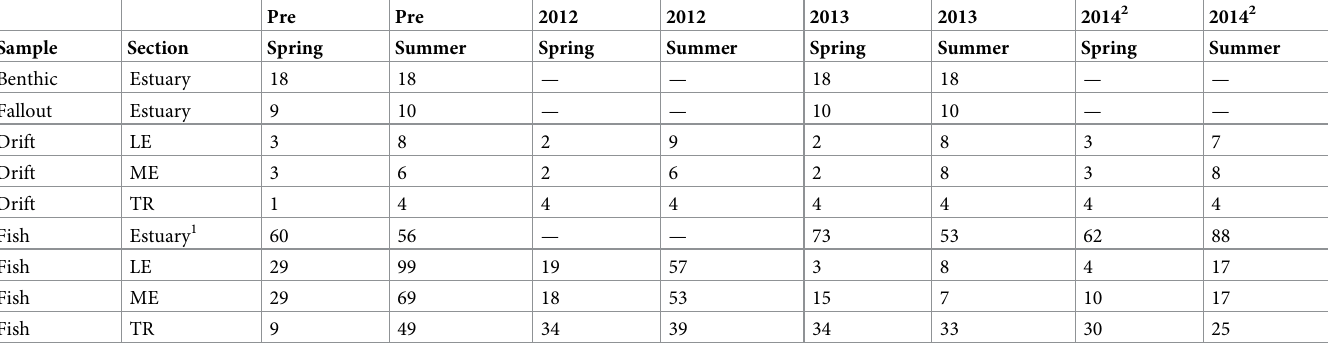
Table 1. Number of invertebrate and fish diet samples collected in the estuary and river before (Pre) and during (2012-2014) dam removal.